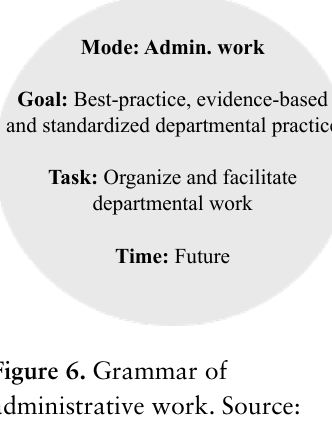
Figure 6. Grammar of